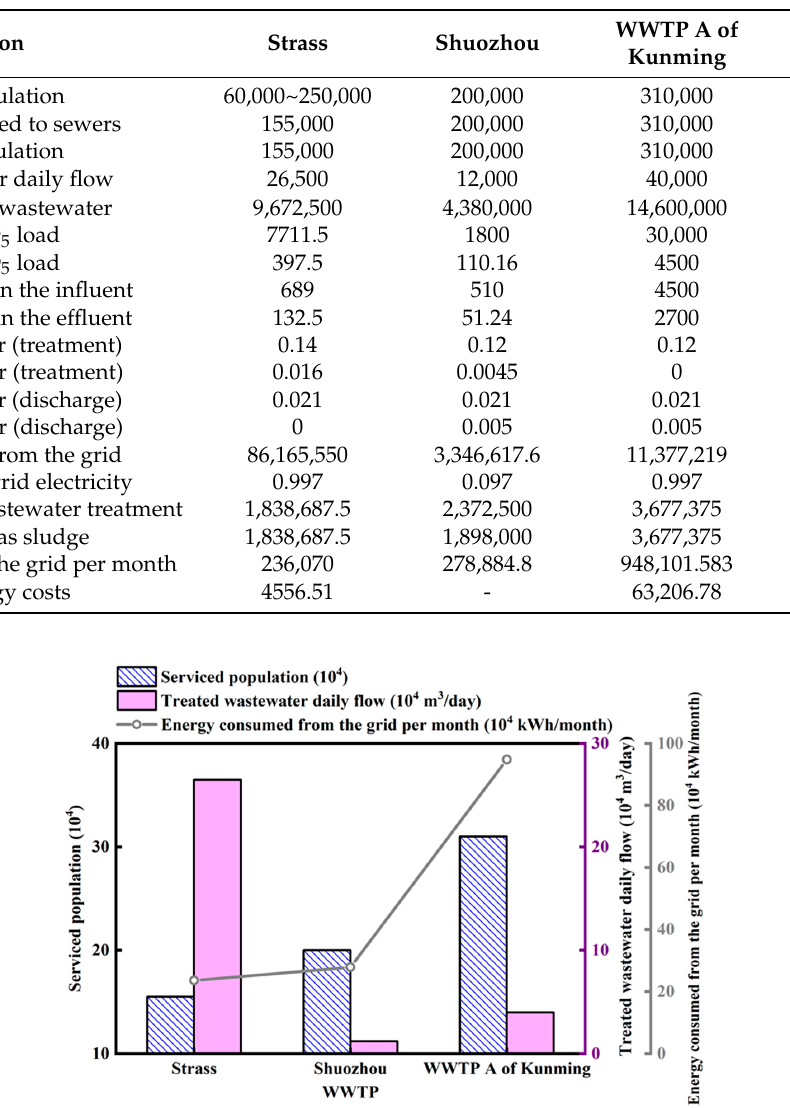
Table 6. The initial GHG evaluation stage input into the ECAM tool.